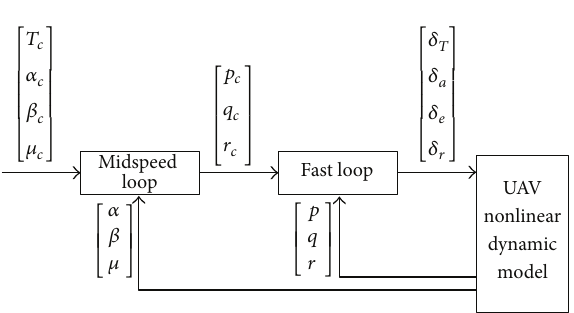
Figure 2: The structure of control laws based on the nonlinear dynamic